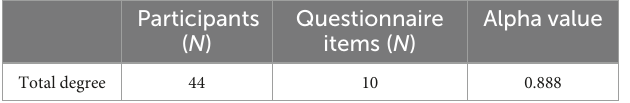
TABLE 4 Result of the Cronbach alpha coefficient for the second dimension.